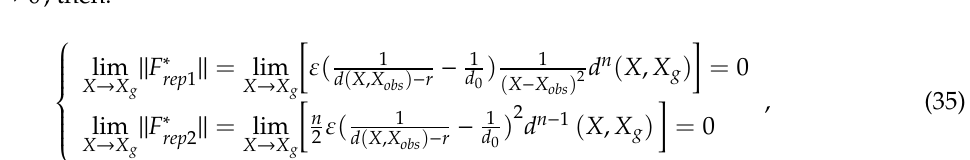
Figure 10. Mathematical characteristics when n>1.